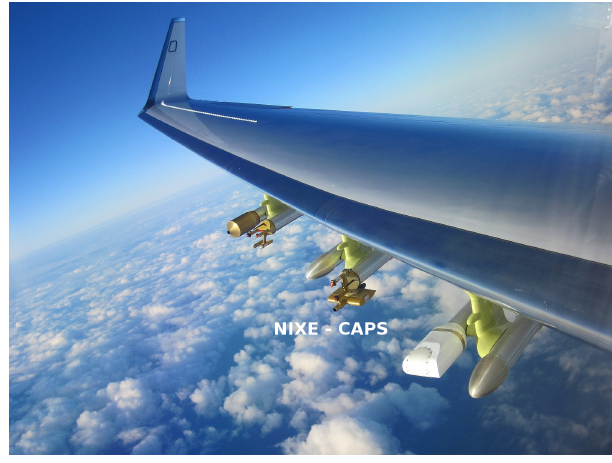
Figure 7. NIXE underwing mounting on HALO (photo: Armin Af-